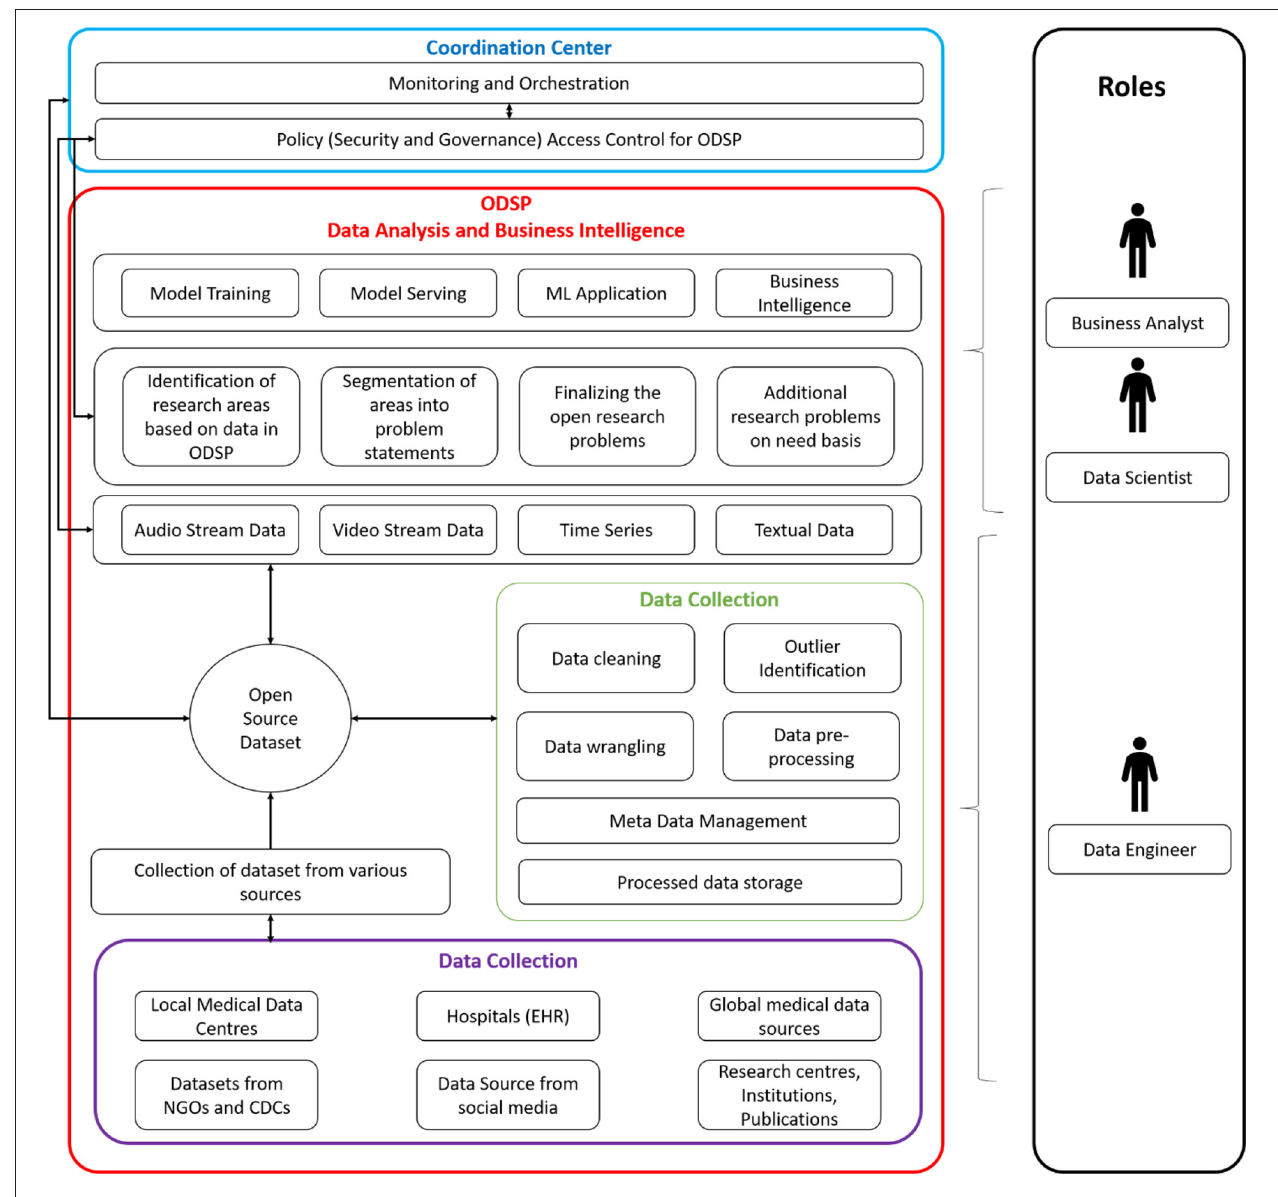
FIGURE 3 | Open Architecture of Data Management for Health